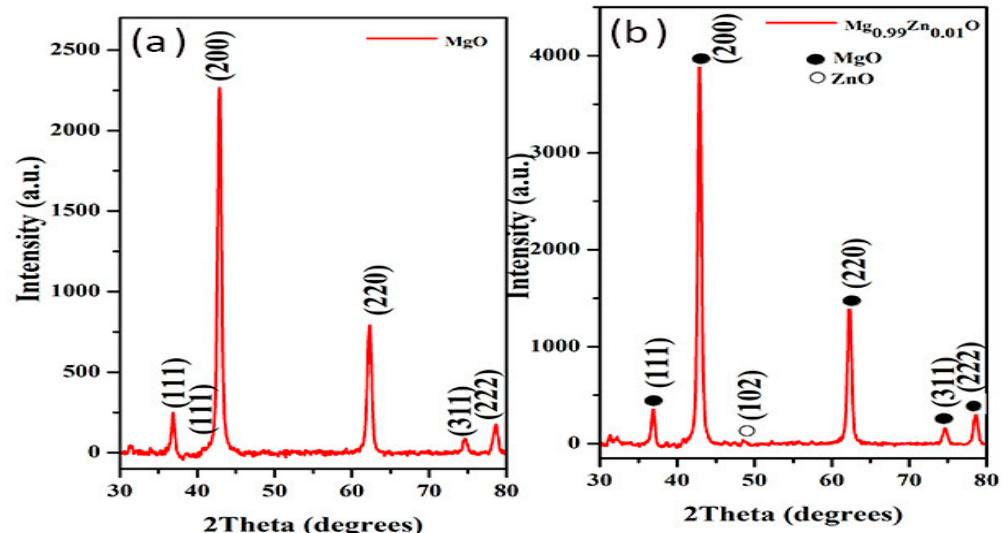
Figure 2. XRD pattern of ( a ) MgO and ( b ) Mg 0.99 Zn 0.01 O.